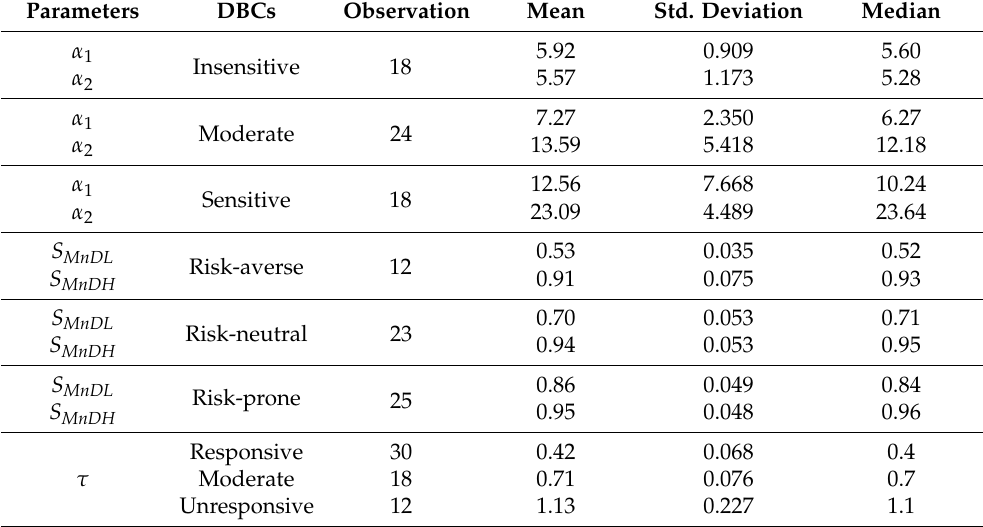
Table 2. Clustering results of